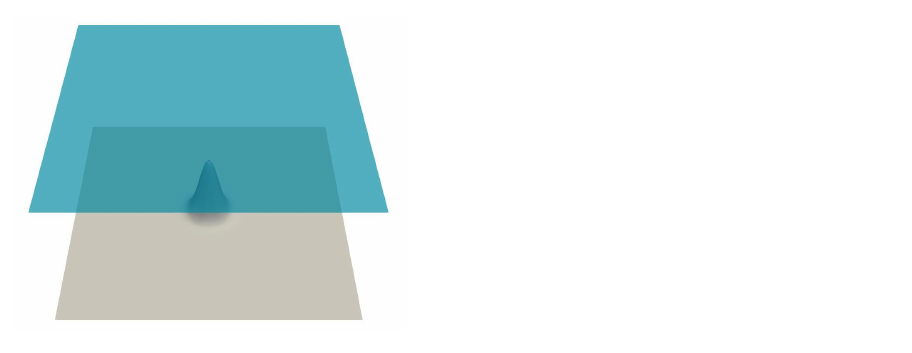
Figure 12. Bottom and the initial lake at rest free surface condition for the stationary problem (68) (dispersive Gavrilyuk–Favrie equations). Table 6. Numerical validation of the well-balanced and non well-balanced methods for the stationary problem (68) (dispersive Gavrilyuk–Favrie equations). Table contains L 1 errors for the water depth variable h at a final time t = 10 s for Runge–Kutta and ADER DG schemes of order N + 1 = 1, 2, 3, 4. Uniform Cartesian meshes of N x × N y elements has been used.